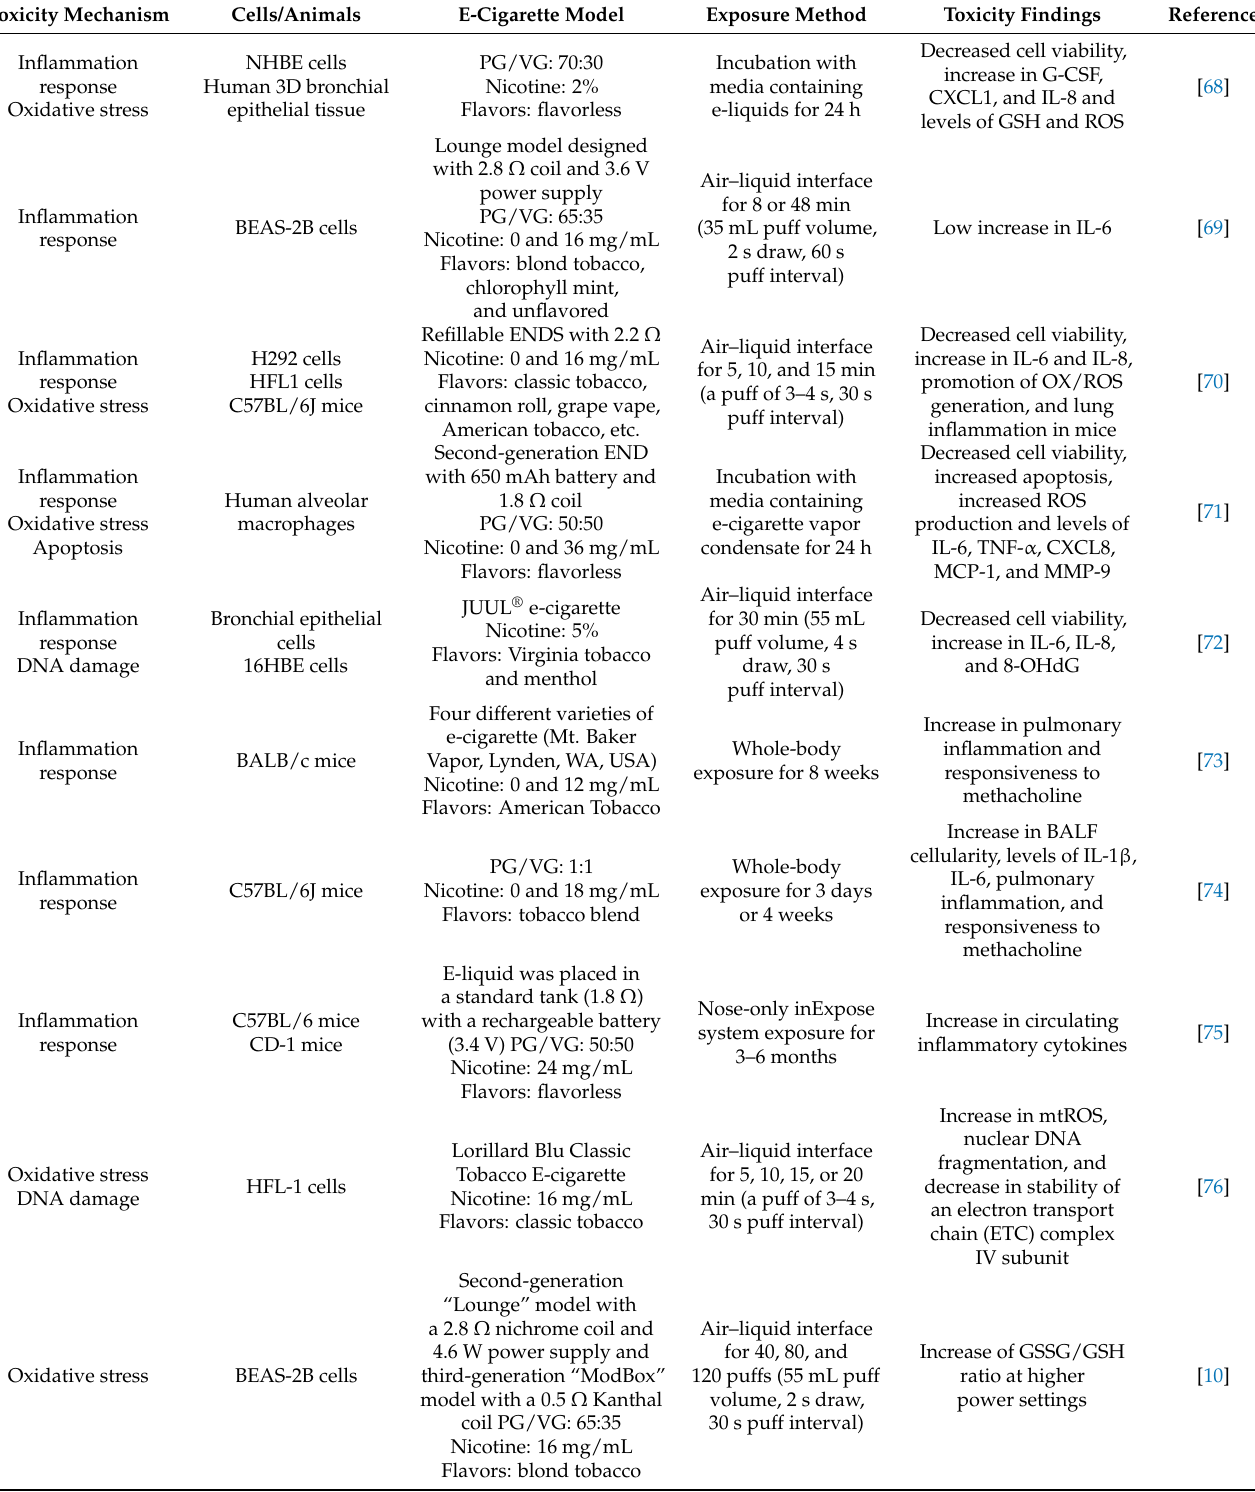
Table 2. Studies of the toxicity mechanisms of